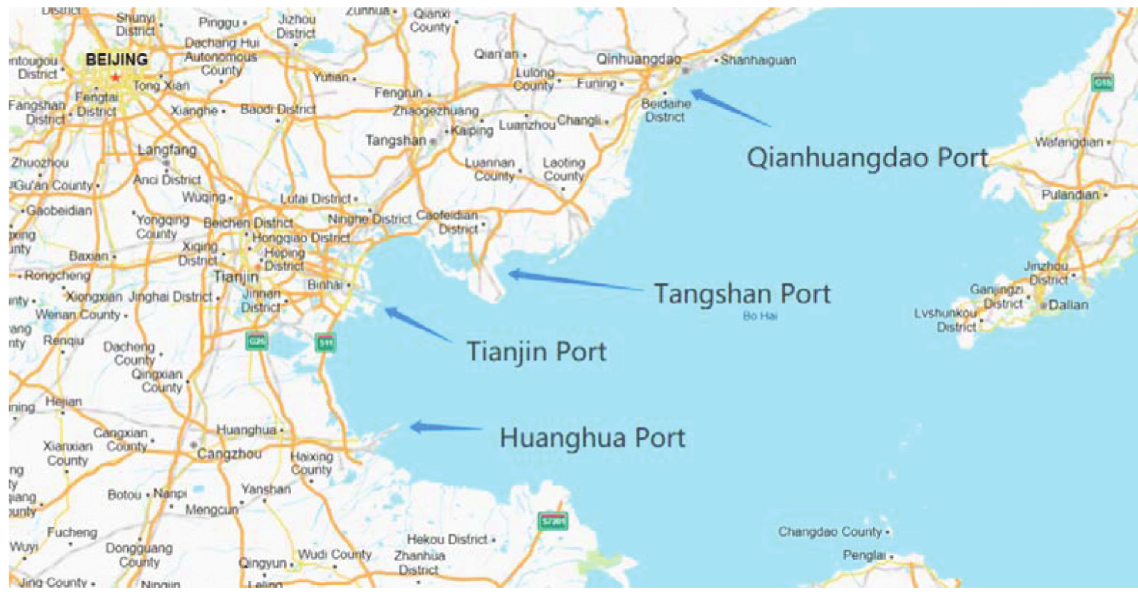
Figure 1: The geographical location of Tianjin-Hebei Port